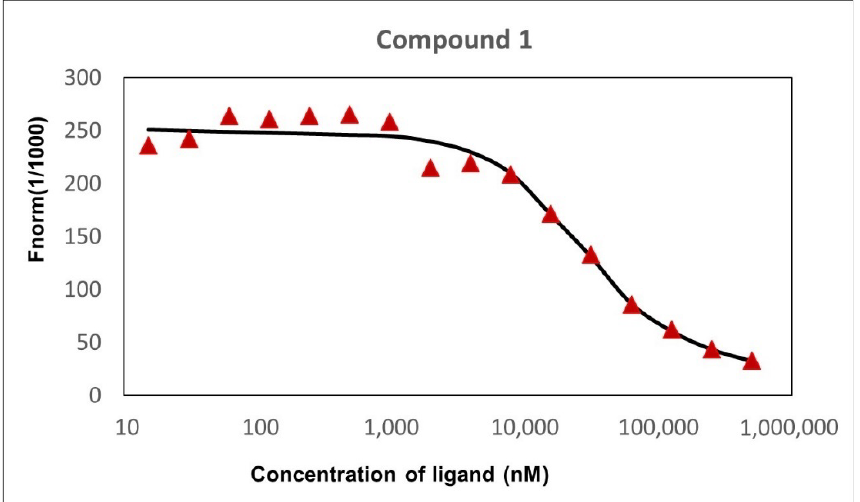
Figure 5. Dependence of normalized fluorescence on the concentration of compound 1 , K D = 27.2 ± 0.9 μM.